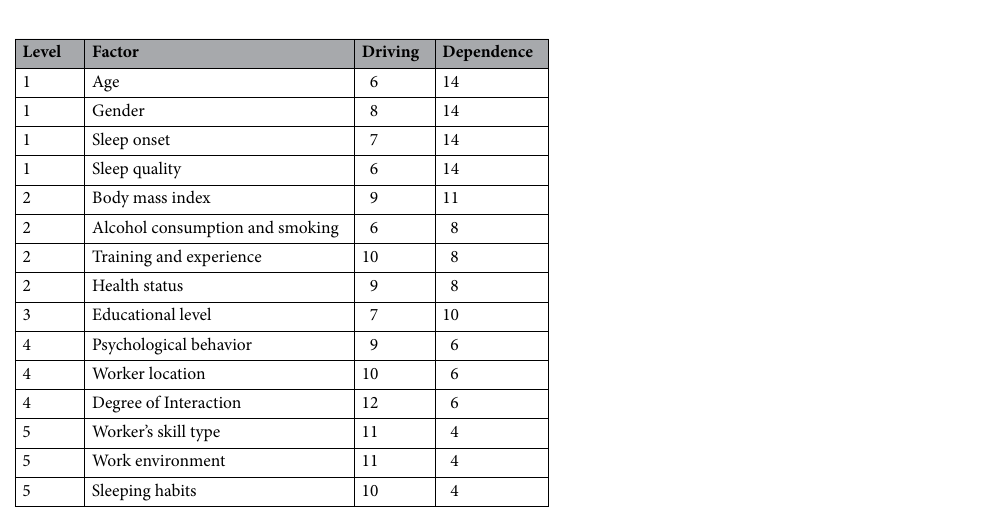
Table 6. Dependence and driving powers of